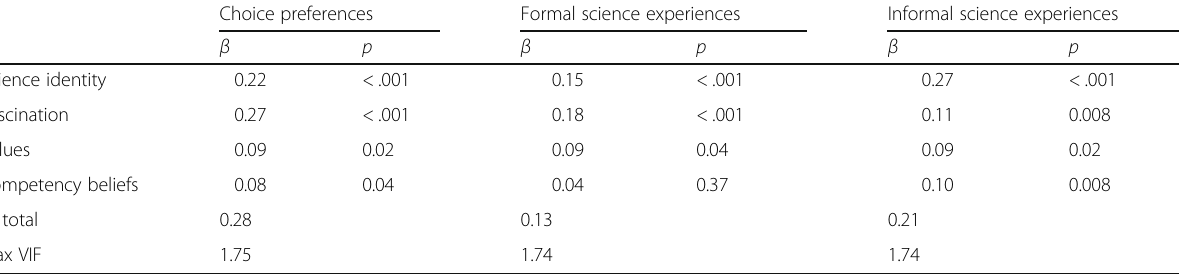
Table 5 Multiple regressions of attitudinal factors predicting different out-of-school science experiences controlling for sex and race/ ethnicity, along with overall model R 2 and the largest VIF value in each